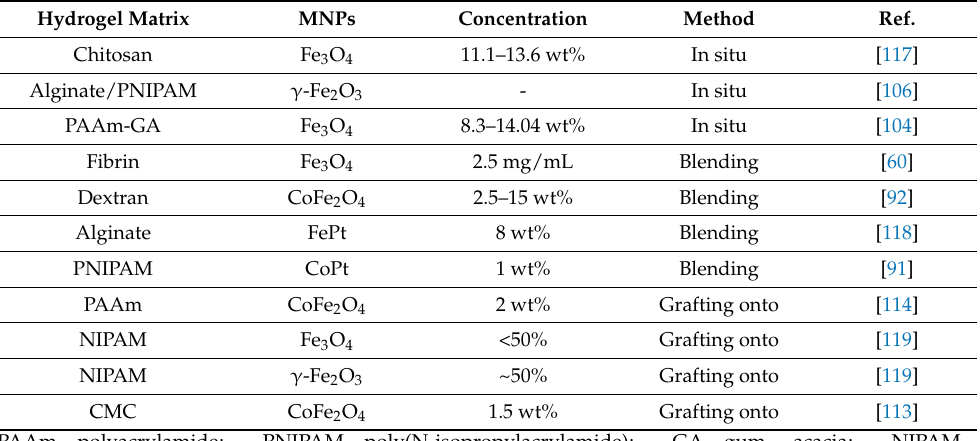
Table 1. Various types of magnetic hydrogels and their mode of synthesis. Hydrogel